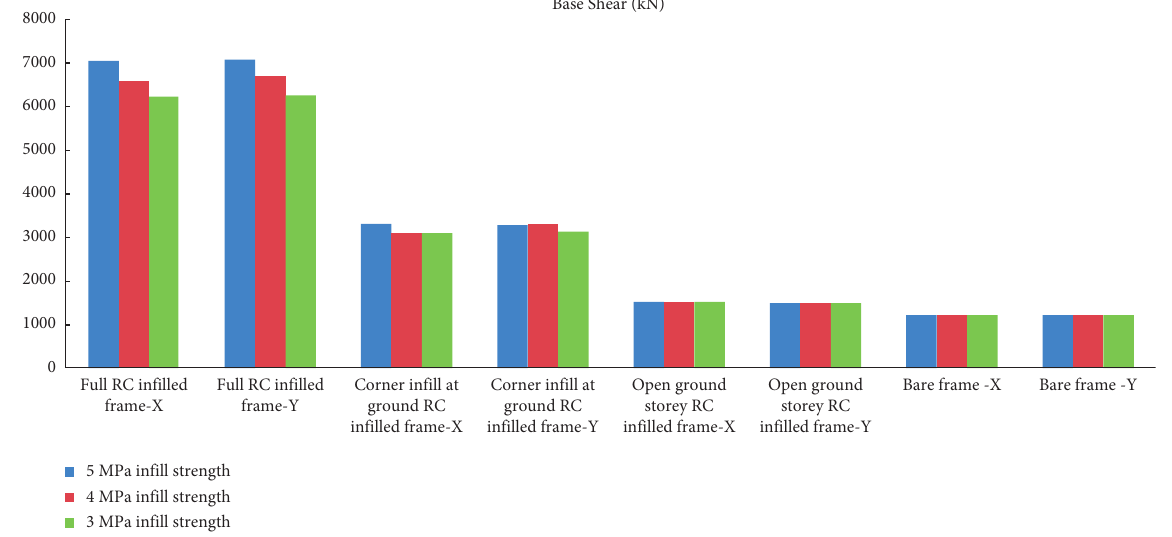
Figure 8: Comparison of base shear from all structural